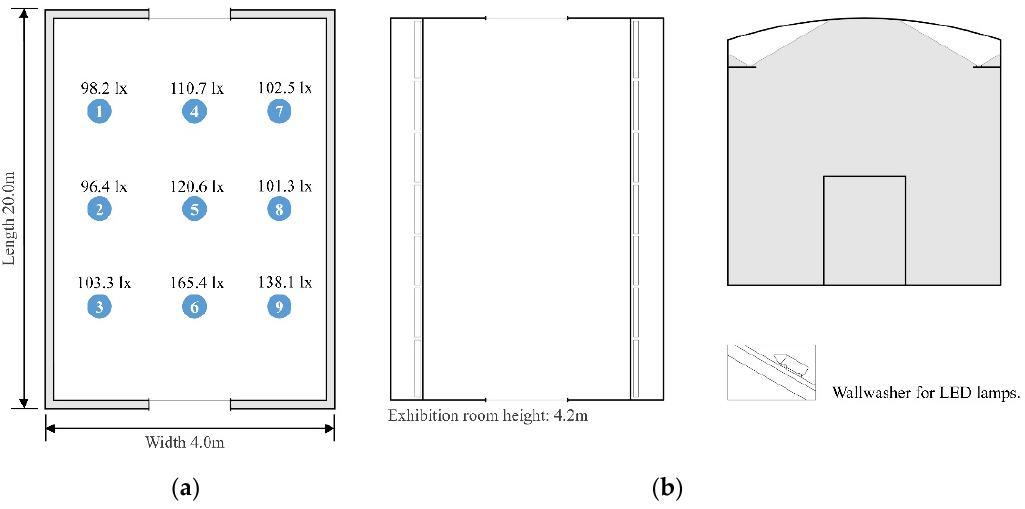
Figure 7. The Aichi Prefectural museum of art building interior. ( a ) Illuminance plane spot test. ( b ) The arrangement and elevation of the indirect lighting display source.